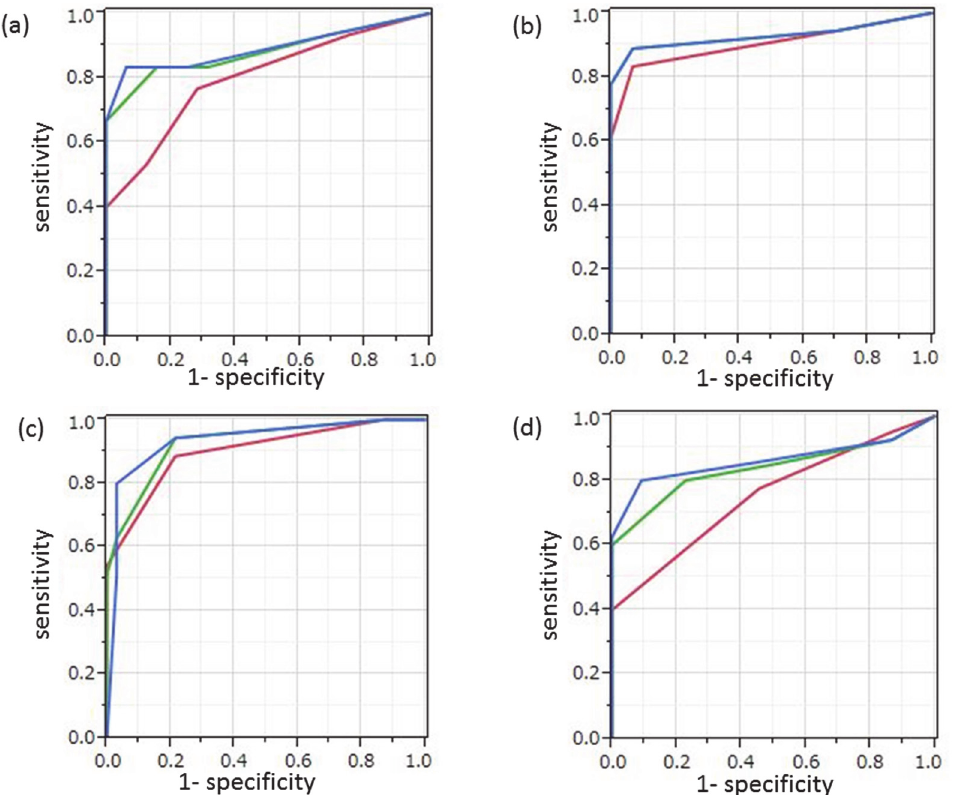
Fig 1. ROC curves for protocol A (red), protocol B (green), and protocol C (blue) in depicting (a) local recurrence, (b) intrapelvic lymph node recurrence, (c) intrapelvic peritoneal dissemination, and (d) intrapelvic recurrence on a per-patient basis. (a) The AUCs calculated for protocol B (0.881) and protocol C (0.892) were significantly higher than that for protocol A (0.800). (b) The AUC calculated for protocols B and C (0.927) was not significantly higher than that for protocol A (0.902). (c) The AUCs calculated for protocol B (0.924) and protocol C (0.931) were significantly higher than that for protocol A (0.885). (d) The AUCs calculated for protocol B (0.838) and protocol C (0.862) were significantly higher than that for protocol A (0.753).